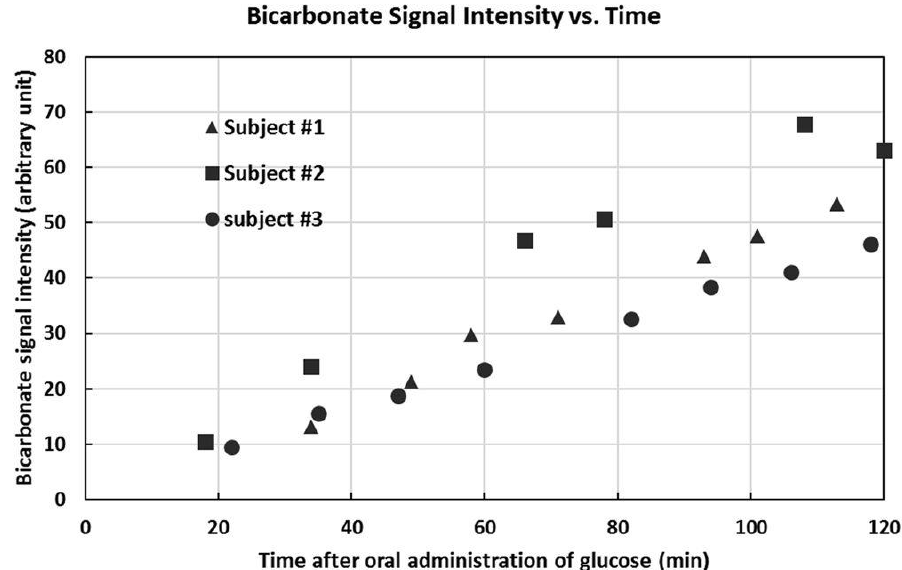
Figure 4. Bicarbonate signal intensities as a function of time after oral administration of [U- 13 C 6 ] glucose. The glucose level was different in different subjects during the scan time. Bicarbonate signal increased monotonically (reprinted from ref. [43]. https://creativecommons.org/licenses/by/4.0/).